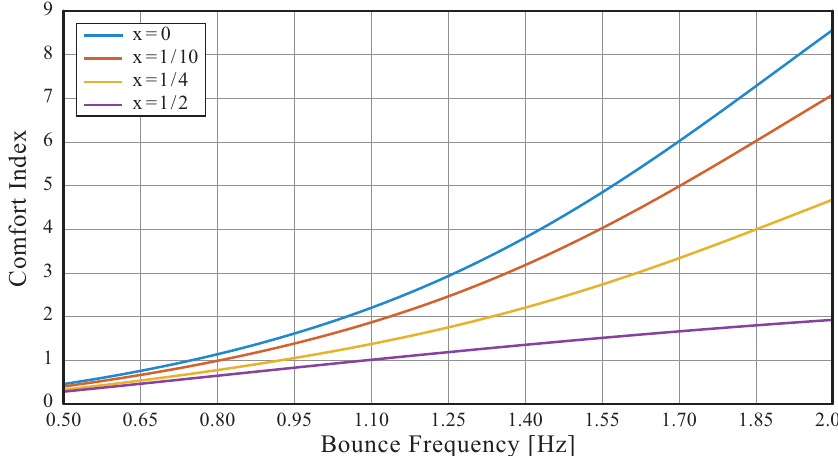
Figure 5. Comfort index at four locations on the beam versus bounce frequency ( f b ).